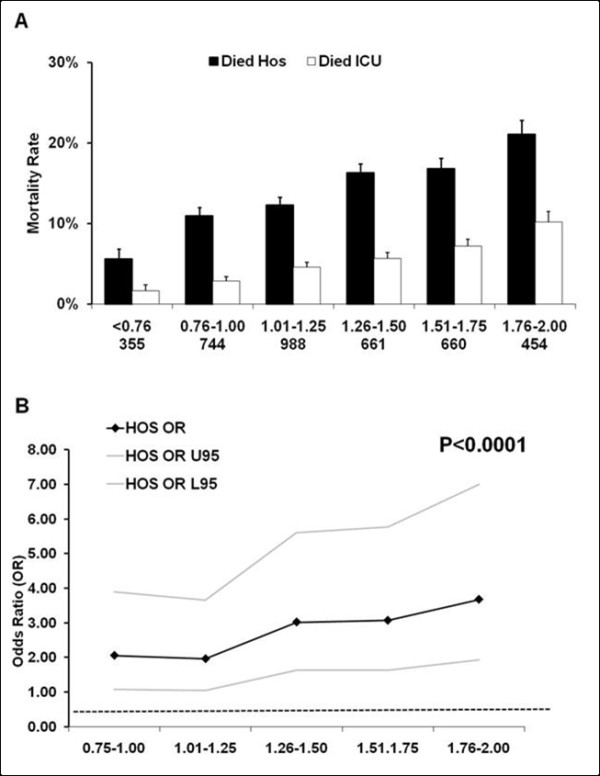
Relationship between time-weighted blood lactate concentration within the normal range and mortality rate. Relationship between time-weighted blood lactate (LacTW) concentration within the reference range and ICU and hospital mortality rate (Panel (a)). The number of patients in each group is expressed as (n). Panel (b) displays the result (adjusted odds ratios (OR) with 95% Confidence Interval (CI)) of a multivariate analysis assessing the association between time-weighted blood lactate concentration (LacTW) within the normal range and hospital mortality. Abbreviations: OR U95; odds ratio upper 95% CI; OR L95, odds ratios lower 95% CI. (All ORs in the multivariate analysis are compared to 0.00 to 0.75 mmol.L-1 group with the horizontal line representing an OR of 1.0.).